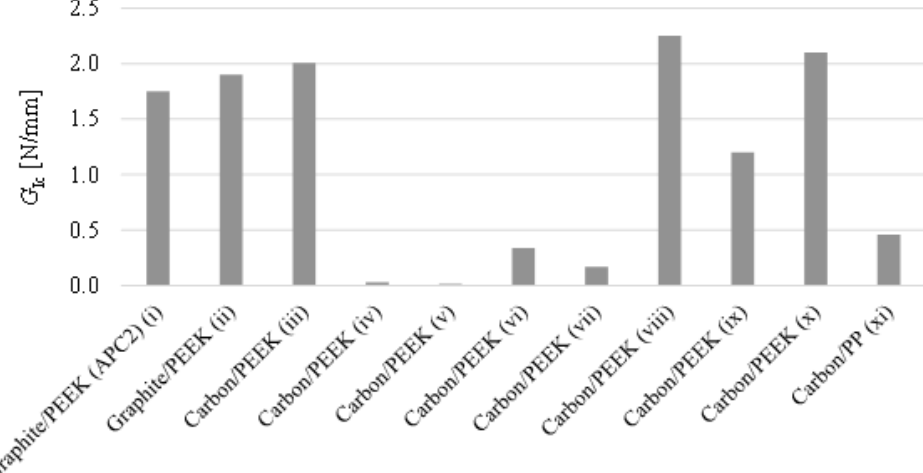
Figure 12. Experimental critical fracture energy release rates (G Ic ) obtained in pure mode I loading fracture tests for several thermoplastic based composites. Legend (joining method, surface treatment):